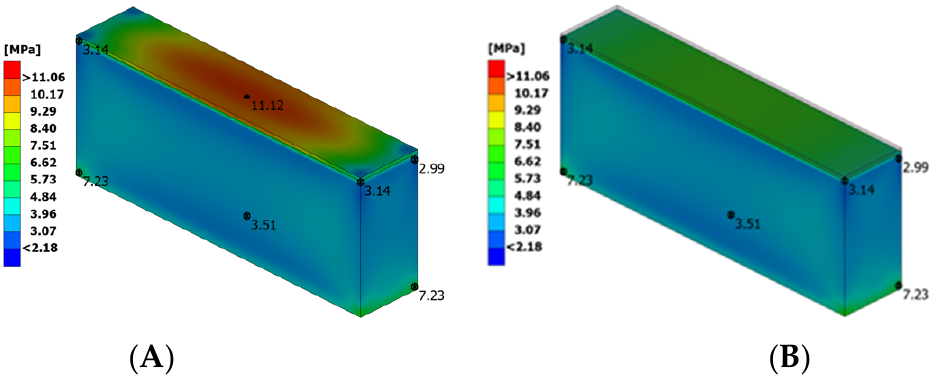
Figure 11. The results of the V02 static analysis (spraying Ni-7Cr-3Fe + 60% WC + polymer 23). ( A ) Stress concentration on the surface layer of spraying; ( B ) stress concentration on the polymer-concrete surface under spraying (the spraying layer is hidden).